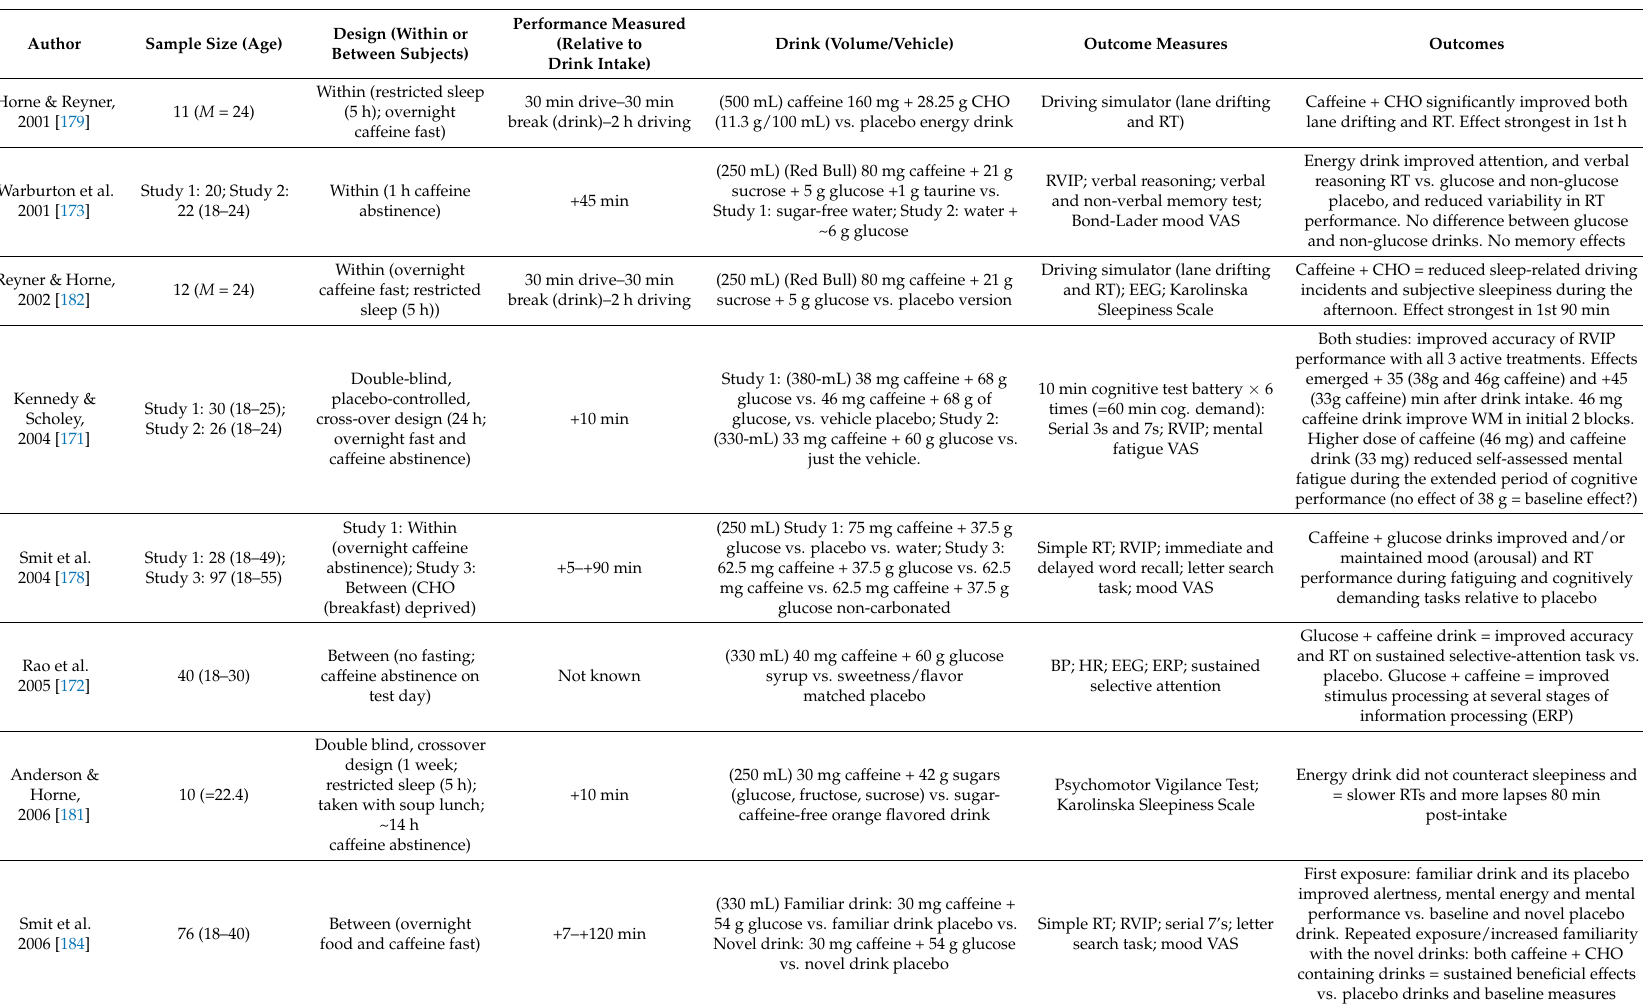
Table 5. Summary of studies examining the effects of caffeine and CHO in combination on cognitive performance and subjective